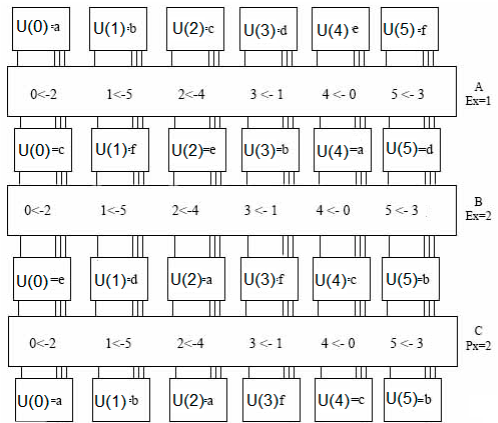
Figure 11. Example permutation pattern for the U vector.